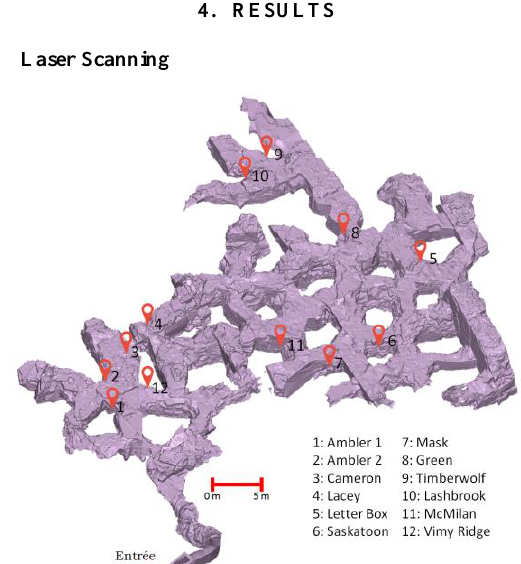
Figure 3. The overall 3D model of the site acquired using TLS and the 12 points of interest modelled using photogrammetry.